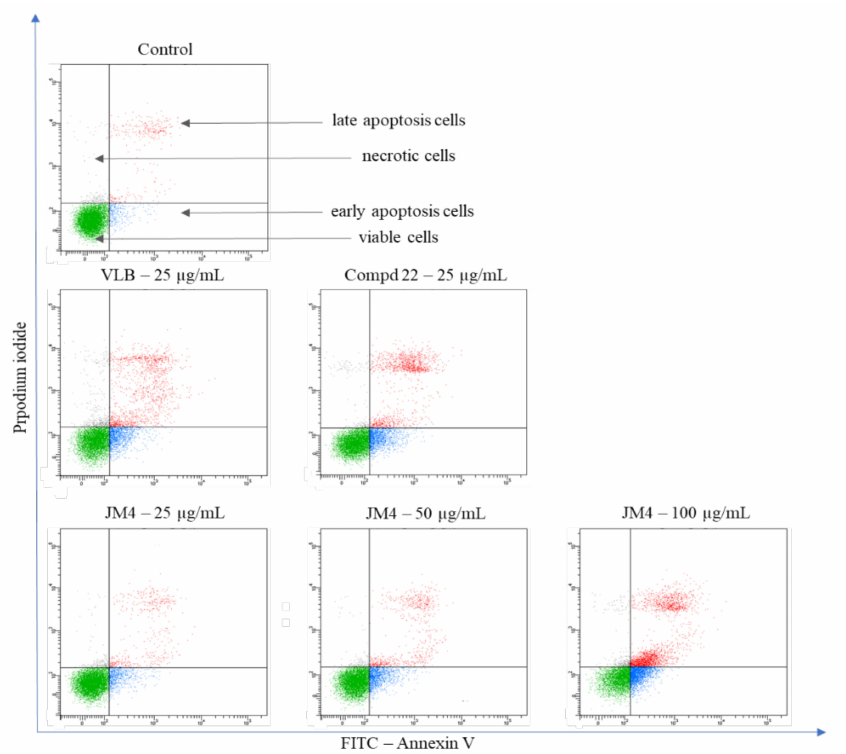
Figure 5. Flow cytometric analysis of C32 melanoma cells after incubation with JM4 (25, 50, 100 µ g/mL), 22 (25 µ g/mL) and vinblastine sulfate (VLB) (25 µ g/mL) for 24 h and subsequent staining with Annexin V and propidium iodide